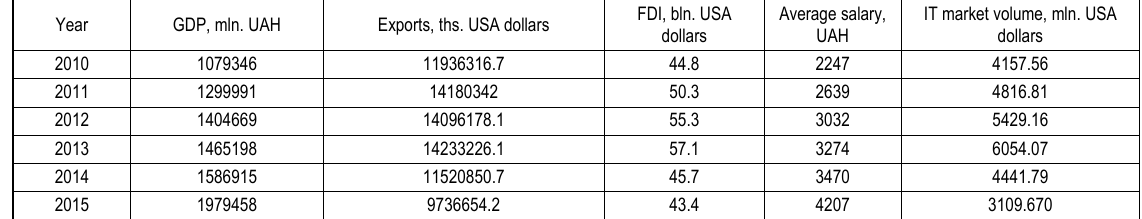
Table 3. Artificial neural network model of the IT market in Ukraine